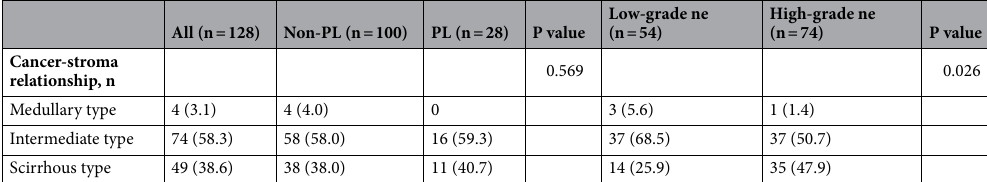
Table 2. Comparison of pathological characteristics in the entire cohort. ne nerve invasion, PL extrapancreatic nerve plexus invasion, TME tumor microenvironment, UICC Union for International Cancer Control. a All of the patients were diagnosed with M1 due to positive lymph nodes other than the regional lymph nodes.